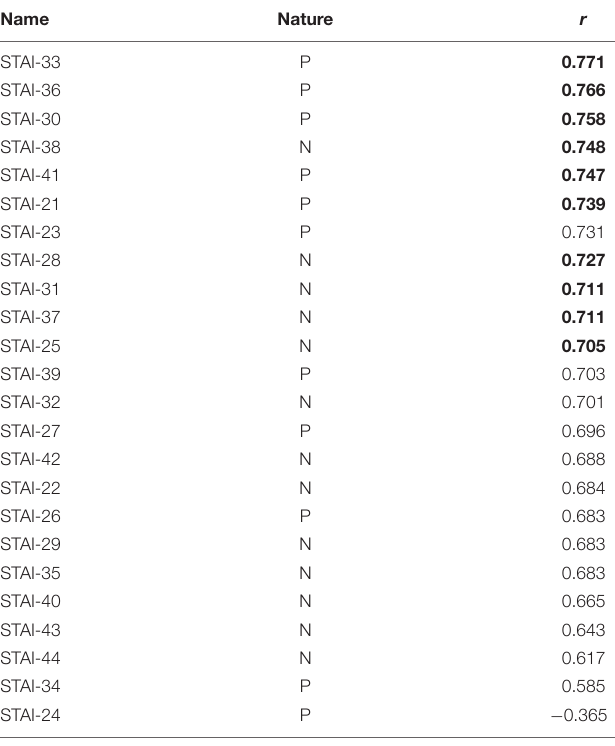
TABLE 4 | Corrected item-total correlations of the STAI-T scale ( n = 1,142).